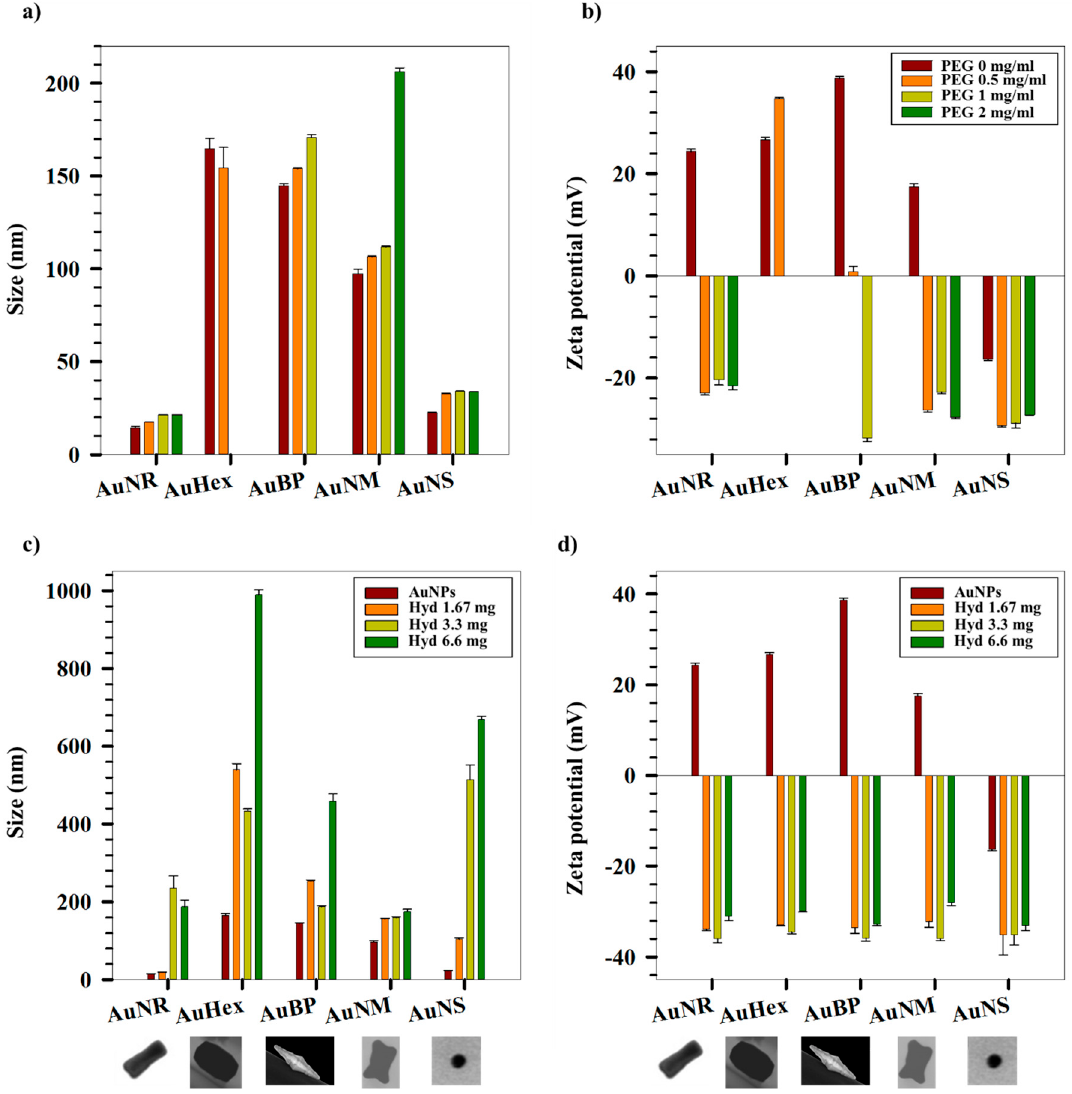
Figure 3. Variation of ( a ) hydrodynamic sizes and ( b ) zeta potentials of AuNPs with different concentrations of PEG. Variation of ( c ) hydrodynamic sizes and ( d ) zeta potentials of AuNPs with different concentrations of hydrogel.